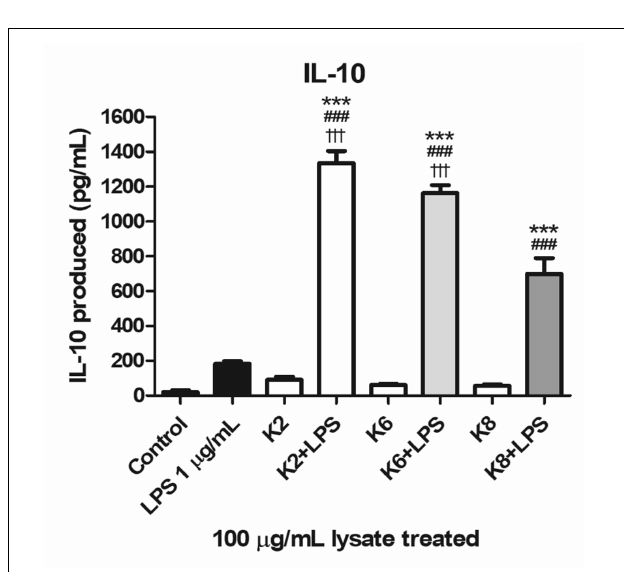
FIGURE 7 | Induction of IL-10 lysates of L. plantarum ATG-K2, ATG-K6, and ATG-K8 in RAW264.7 murine macrophage cells upon LPS challenge. LPS (1 µ g/mL) challenged groups are marked as +LPS in X axis labels. The means of triplicated wells are shown as a representative of duplicated experiments ± SEM. Statistical significance in the figures are as follows: compared to control, ∗ p < 0.05, ∗∗ p < 0.01, and ∗∗∗ p < 0.001; to the LPS group, ## p < 0.01, ### p < 0.001; to the K8+LPS group ††† p <